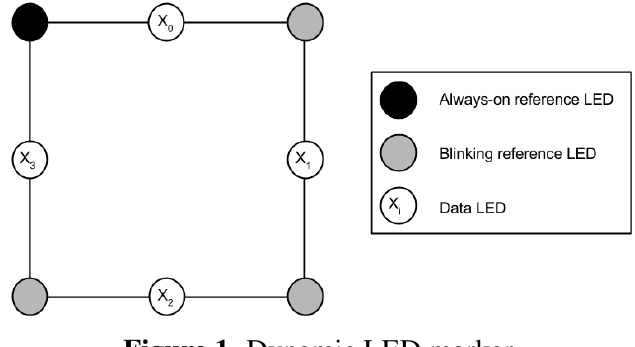
Figure 1. Dynamic LED